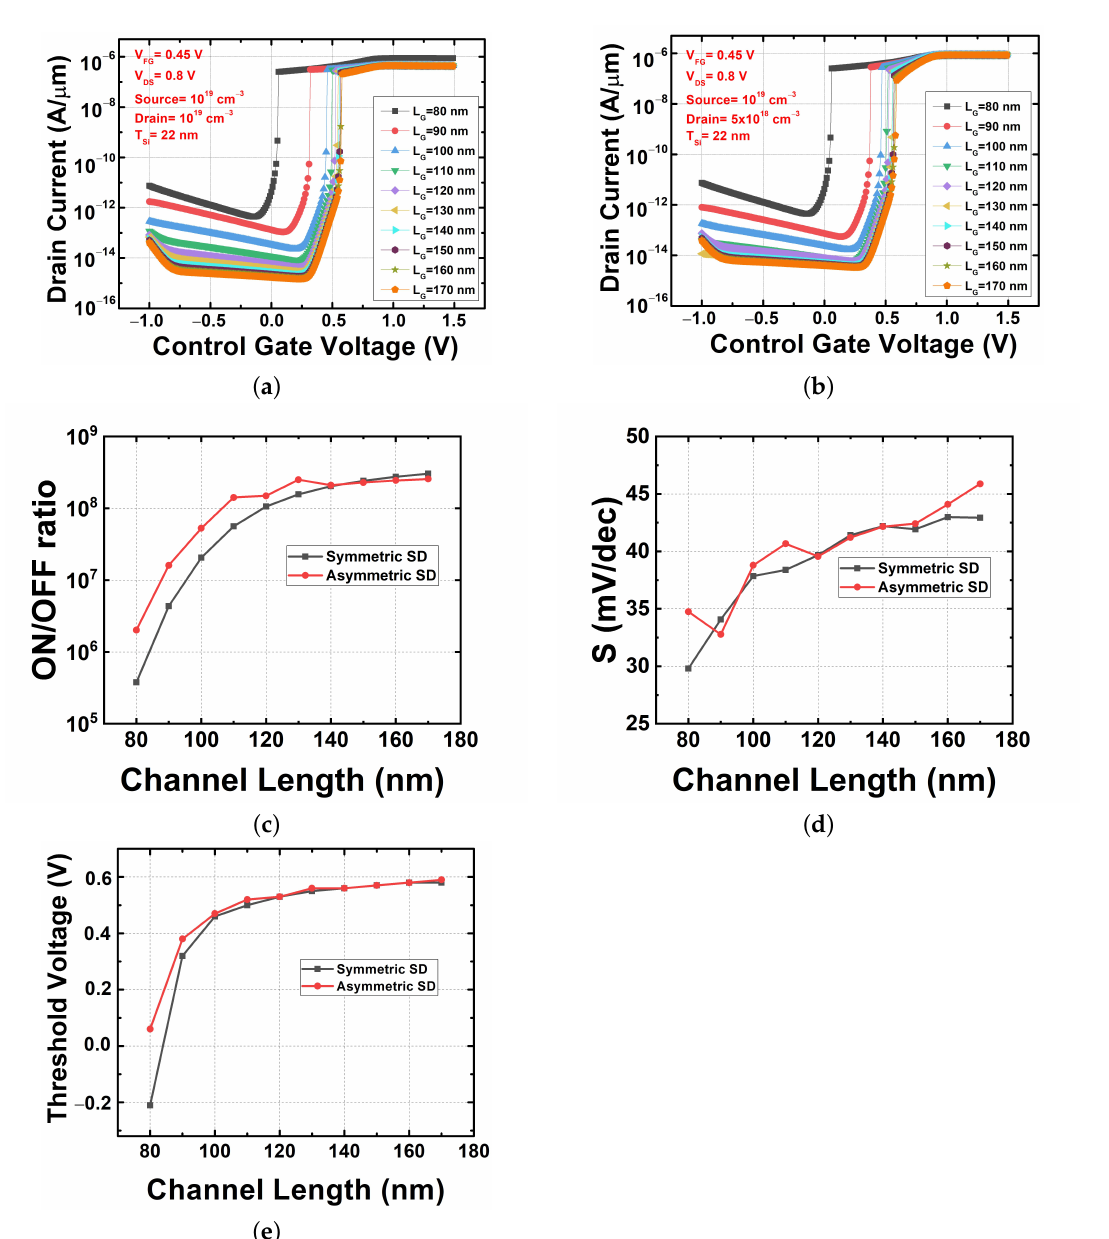
Figure 7. Electrical characteristics with channel length variation. ( a ) Transfer characteristics of symmetric source/drain FBFET, ( b ) transfer characteristics of asymmetric source/drain FBFET, ( c ) on– off current ratio in both FBFETs, ( d ) subthreshold swing in both FBFETs, and ( e ) threshold voltage in both